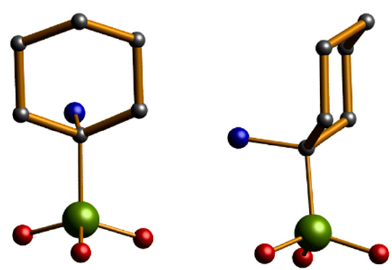
Figure 2. The structure of (1-amino-1-cyclohexyl) phosphonic acid. Scheme: P, green; O, red; C, grey; N, cyan; (H omitted for clarity).